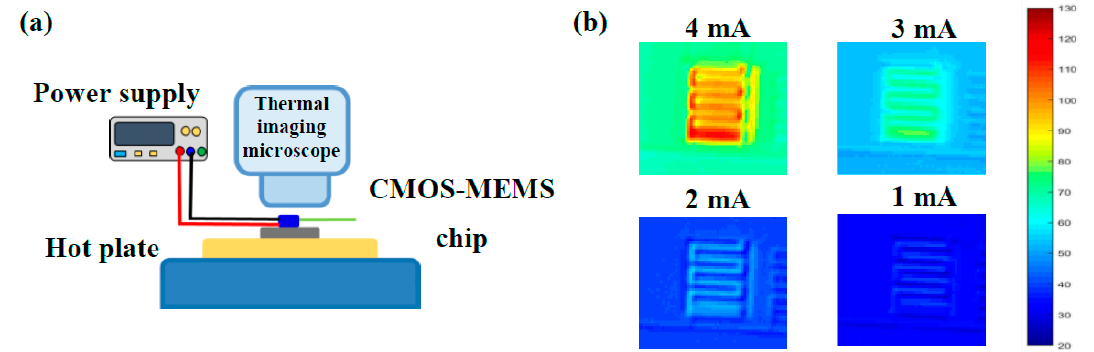
Figure 6. ( a ) Experimental setup to characterize the temperature variation of heater, and ( b ) measurements of the variation of input current with heater